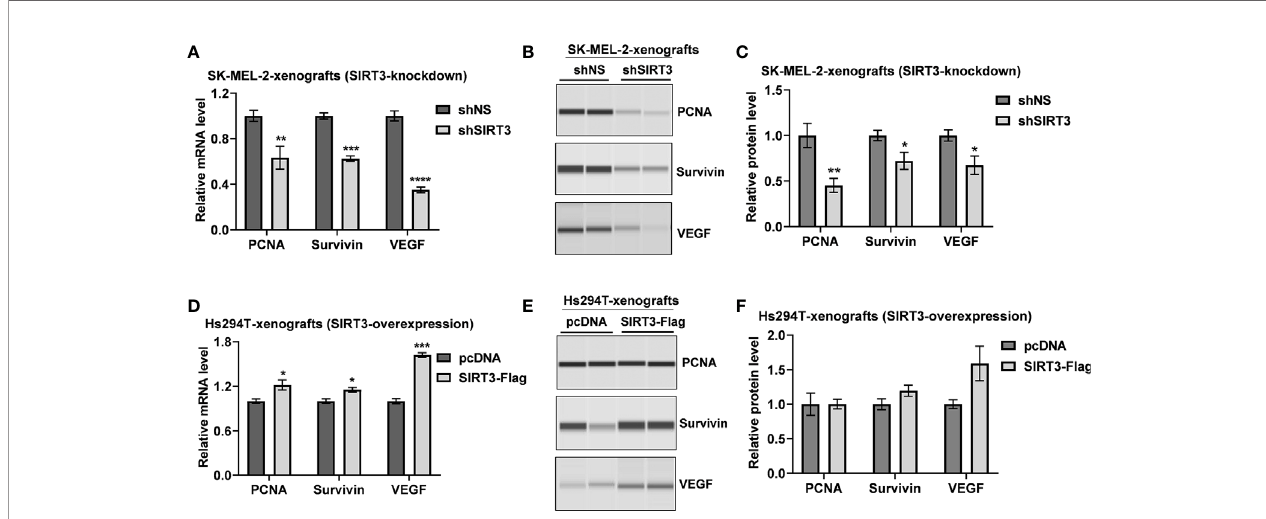
FIGURE 2 | Effect of SIRT3-knockdown and overexpression on the key tumor markers related to cell proliferation, survival and angiogenesis. Utilizing tumor tissues from SIRT3-knockdown (shSIRT3- SK-MEL-2) melanoma cell xenografts, (A) RT-qPCR and (B) Wes ProteinSimple analyses were performed for PCNA, Survivin and VEGF mRNA and protein levels. Next, utilizing tumor tissues from SIRT3-overexpressing (Hs294T-SIRT3-Flag) melanoma cell xenografts, (C) RT-qPCR and (D) Wes ProteinSimple analyses were performed for PCNA, Survivin and VEGF mRNA and protein levels. ACTB was used as an endogenous control for transcripts analysis. The protein quantitative data were normalized to the total capillary area of the Total Protein Assay of the same sample. Data are presented as the mean ± SEM of three biological pools (n = 6) with statistical signi fi cance (multiple t-test, *p < 0.05, **p < 0.01, ***p < 0.001, ****p < 0.0001). shNS, nonspeci fi c shRNA; shSIRT3, SIRT3-knockdown; pcDNA (empty vector); SIRT3-Flag